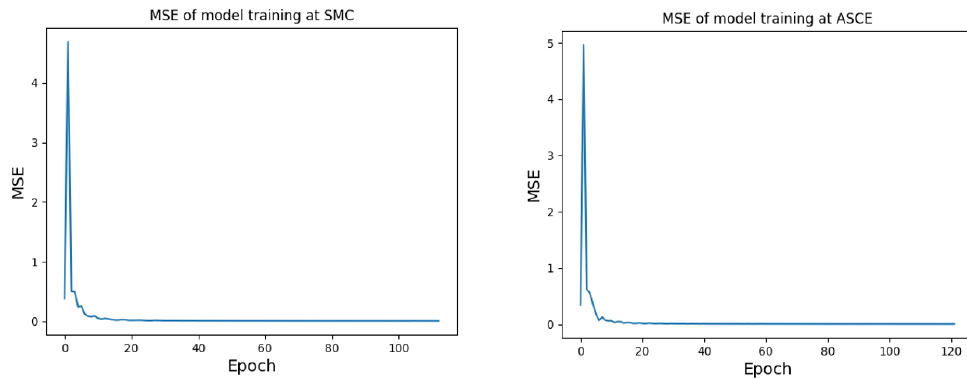
Figure 8. Training error change during the training phase.